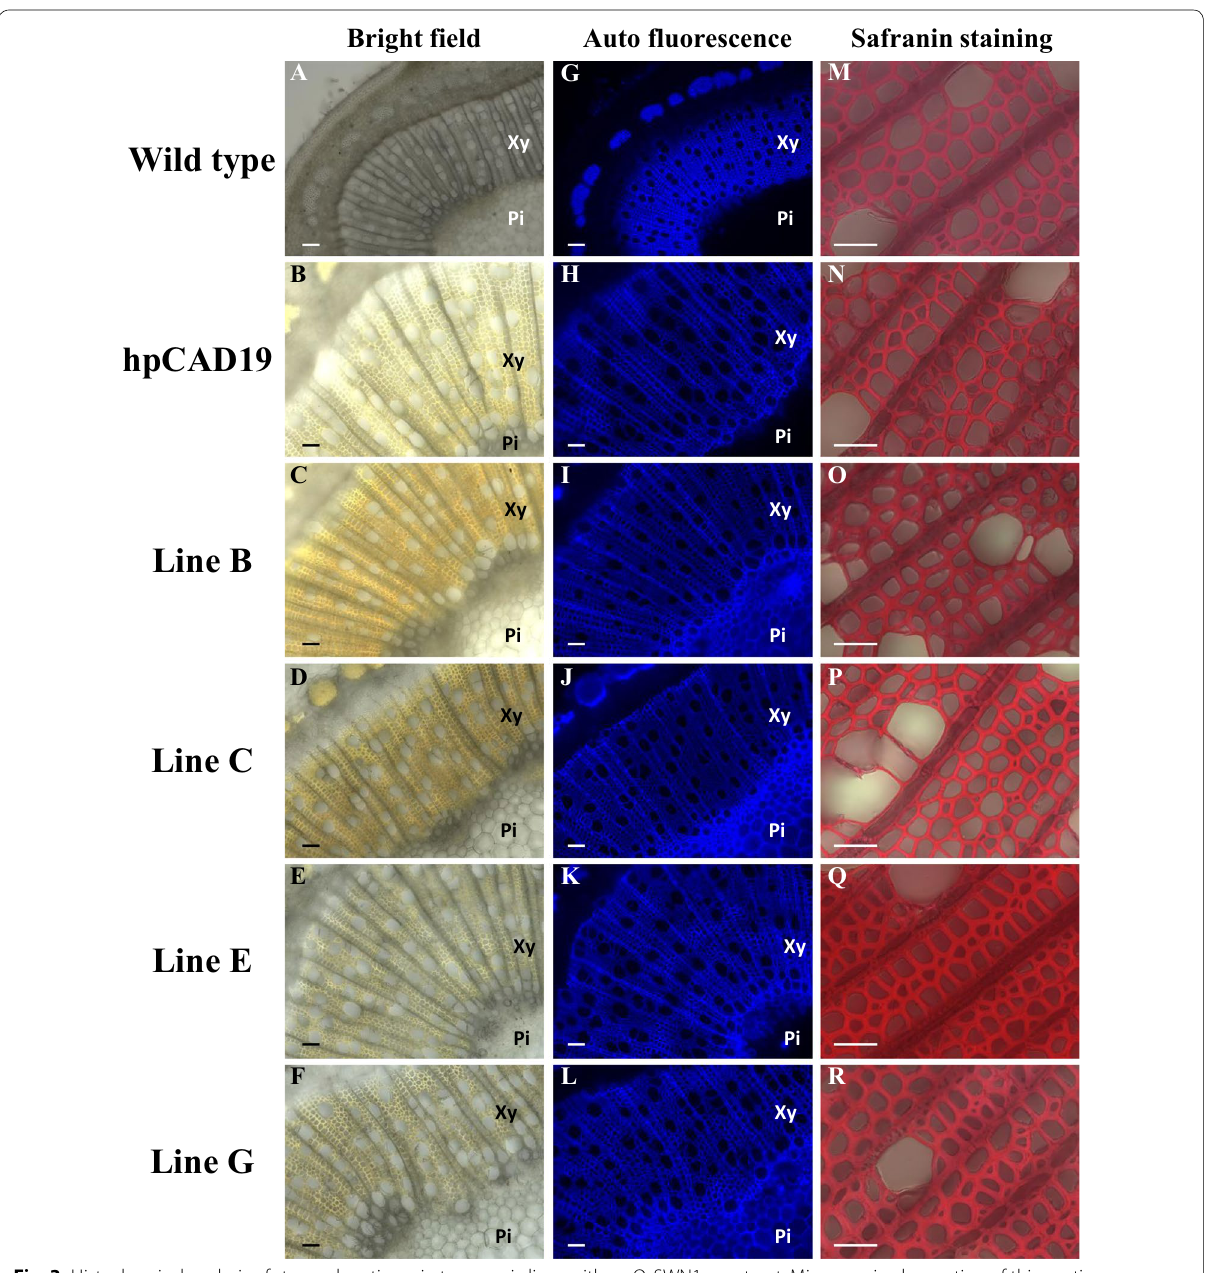
Fig. 3 Histochemical analysis of stem xylem tissue in transgenic lines with an OsSWN1 construct. Microscopic observation of thin sections was performed under a bright field ( A – F ) and UV illumination ( G – L ). Safranin staining ( M – R ) was performed to visualize the differences in cell wall thickness. Xy xylem, Pi pith. Bars 100 μm in A , G ; 50 μm in =